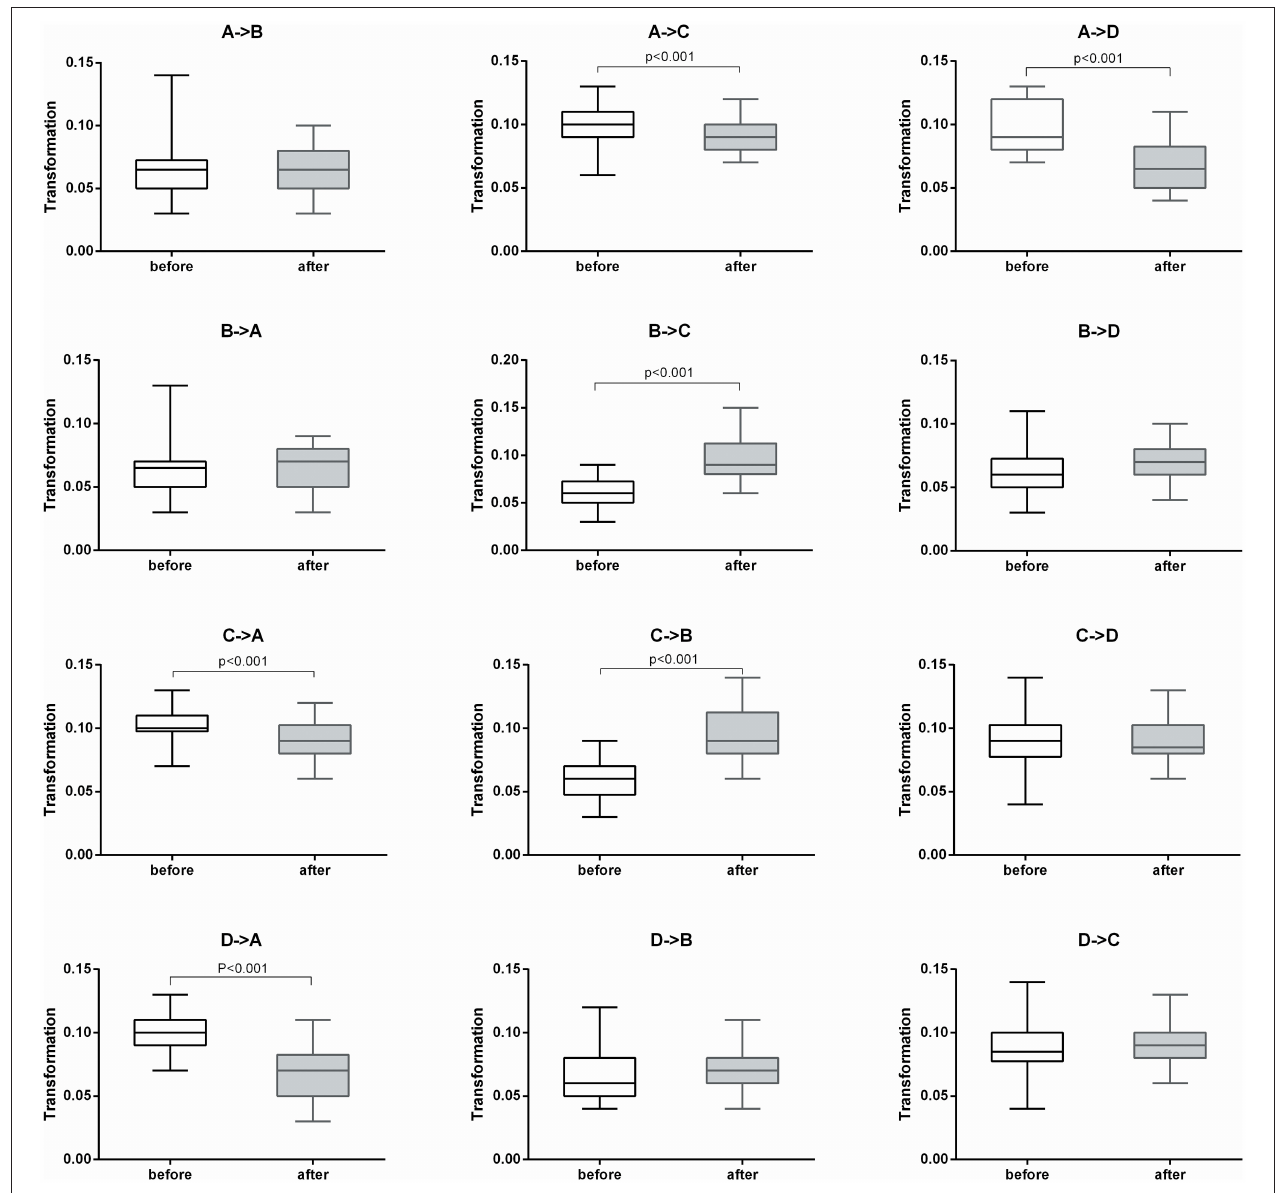
FIGURE 2 | Microstate transitioning probabilities of the four microstate categories before and after treatment ( n =